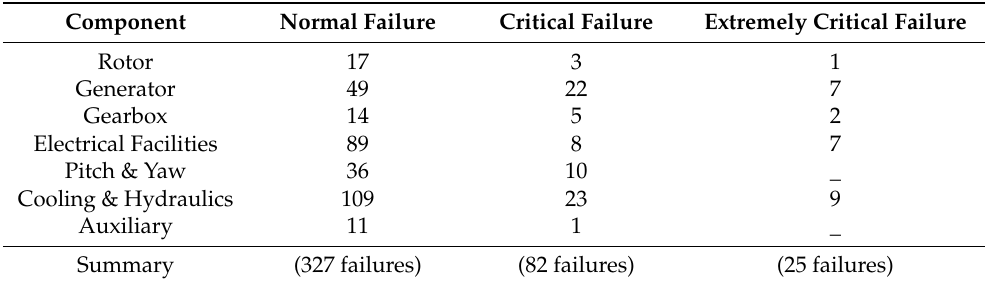
Table 2. Failure criticalities of